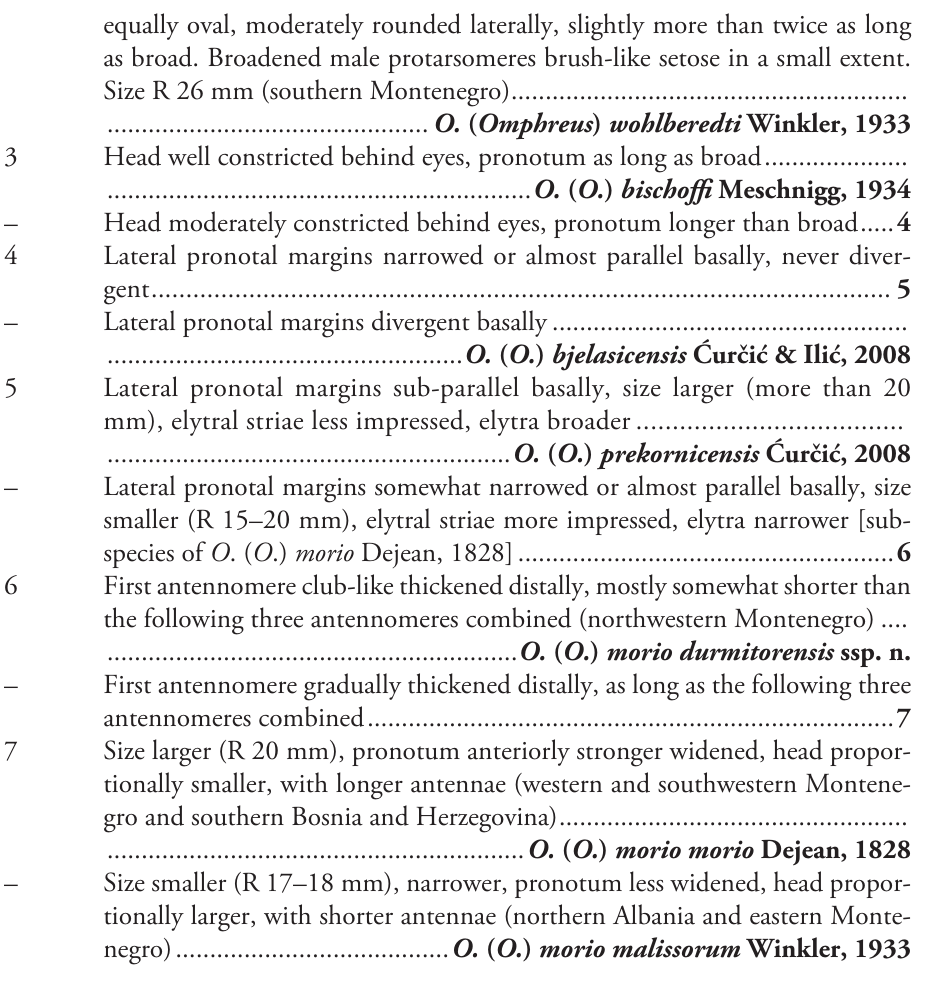
Key to the subspecies of Omphreus ( Omphreus ) morio (modified after Winkler 1933) First antennomere club-like thickened distally, mostly somewhat shorter First antennomere gradually thickened distally, as long as the following three Smaller subspecies (R 15–16 mm), with elytra short (length/width ratio: M